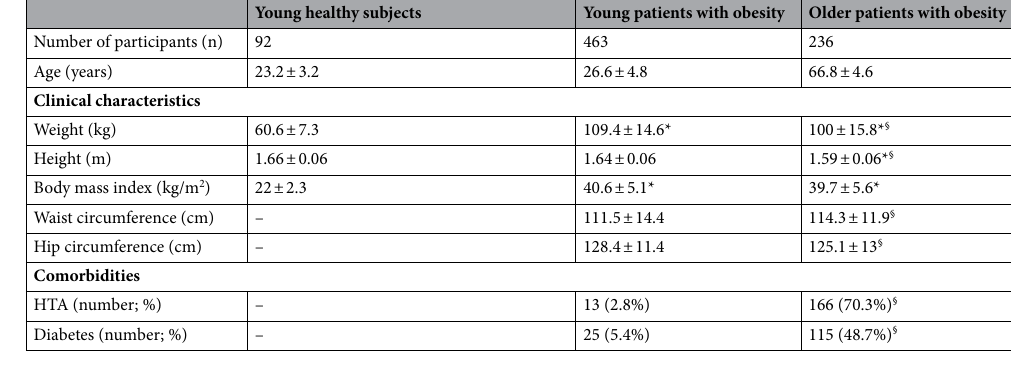
Table 1. Demographic and health characteristics regarding age group and obesity status. Data are presented as the mean ± standard deviation. HTA arterial hypertension. Body mass index for young healthy controls ranged from 18 kg/m 2 ≤ BMI ≤ 25 kg/m 2 and was ≥ 30 kg/m 2 in patients with obesity. We used the Tukey–Kramer procedure to control for the multiple comparison problem. * denotes a significant difference compared to the 18–35 normal-weight women group. § denotes a significant difference compared to 18–35 young women with obesity group.